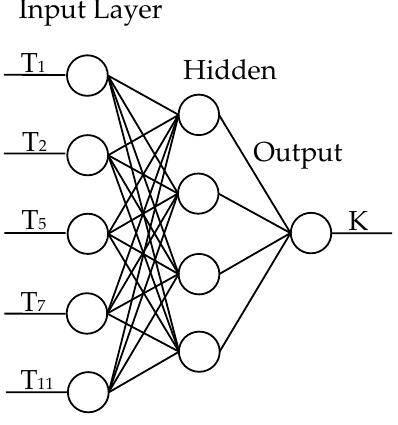
Figure 10. The structure of the neural network model.